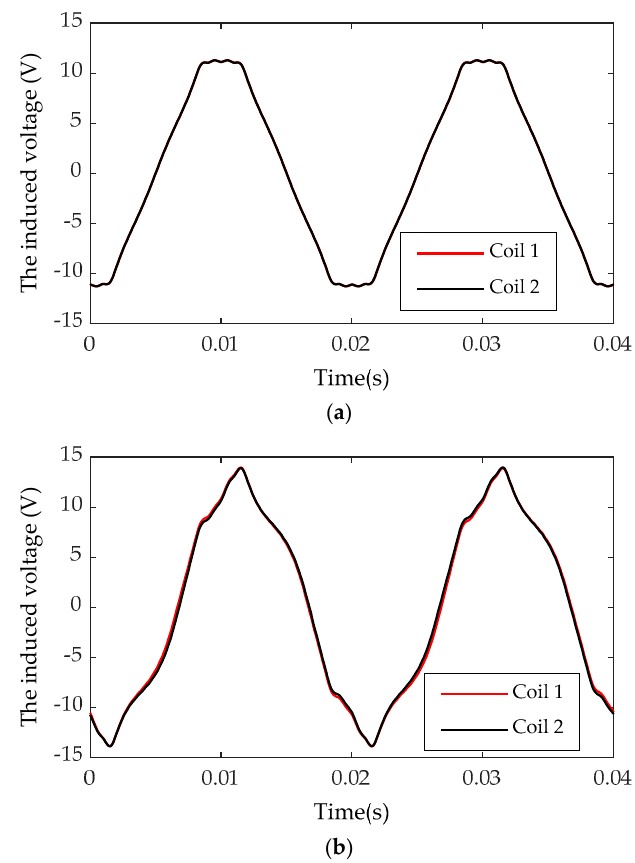
Figure 5. Induced voltage curve of both detection coils: ( a ) no-load; ( b ) rated load.